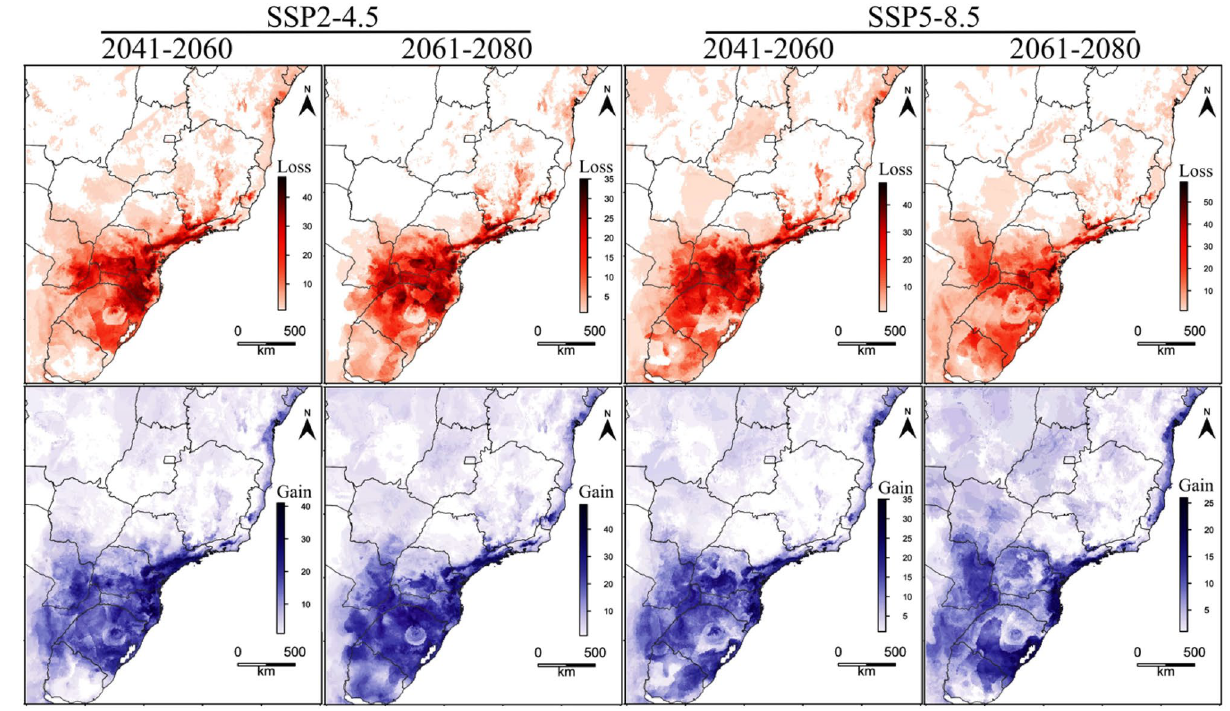
Figure 1. L oss (red) and gain (blue) of BAH for 135 native potential agroforestry plant species in Brazil, obtained by stacking ENM binary predictions, based on different climate scenarios and years. Legend indicates the number of species. Maps created with custom R script. Version R 4.1.1 (https:// www.R- proje ct. org/). Base map source (Brazilian states shapefile) obtained from the Brazilian Institute of Geography and Statistics (https:// www. ibge. gov.